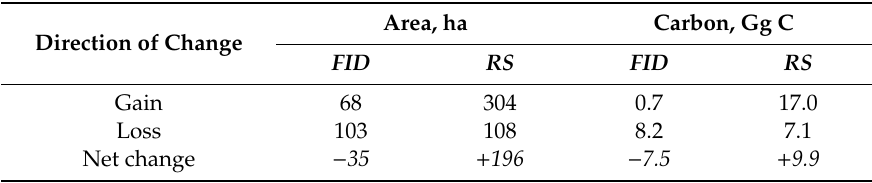
Table 9. Forest gain and loss,